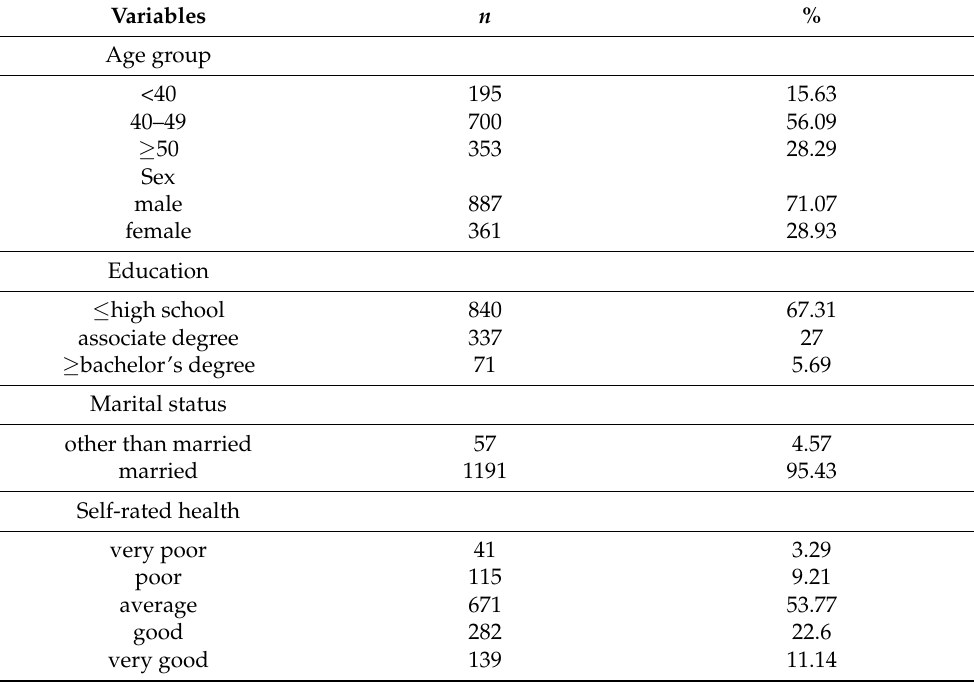
Table 1. Respondents’